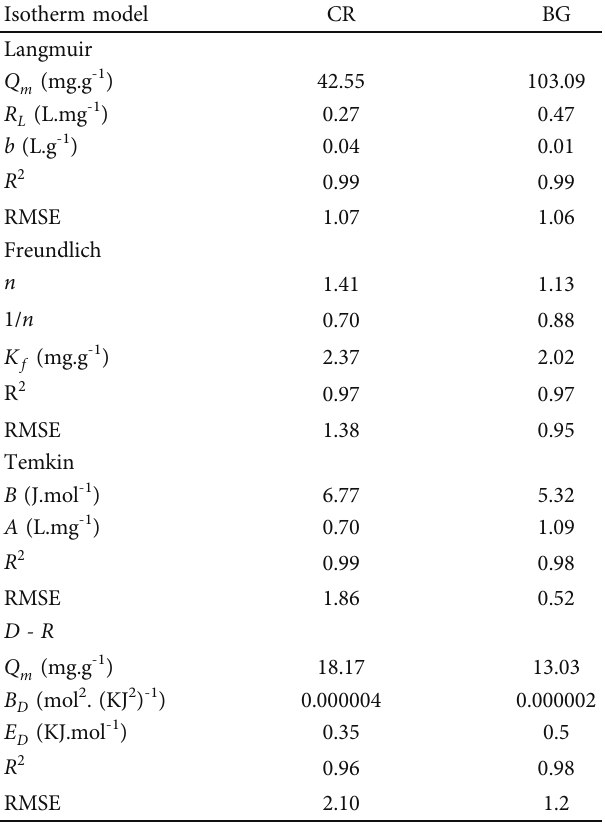
Table 2: A summary of adsorption isothermal data of Congo red (CR) and brilliant green (BG) dyes adsorbed on Brassica oleracea